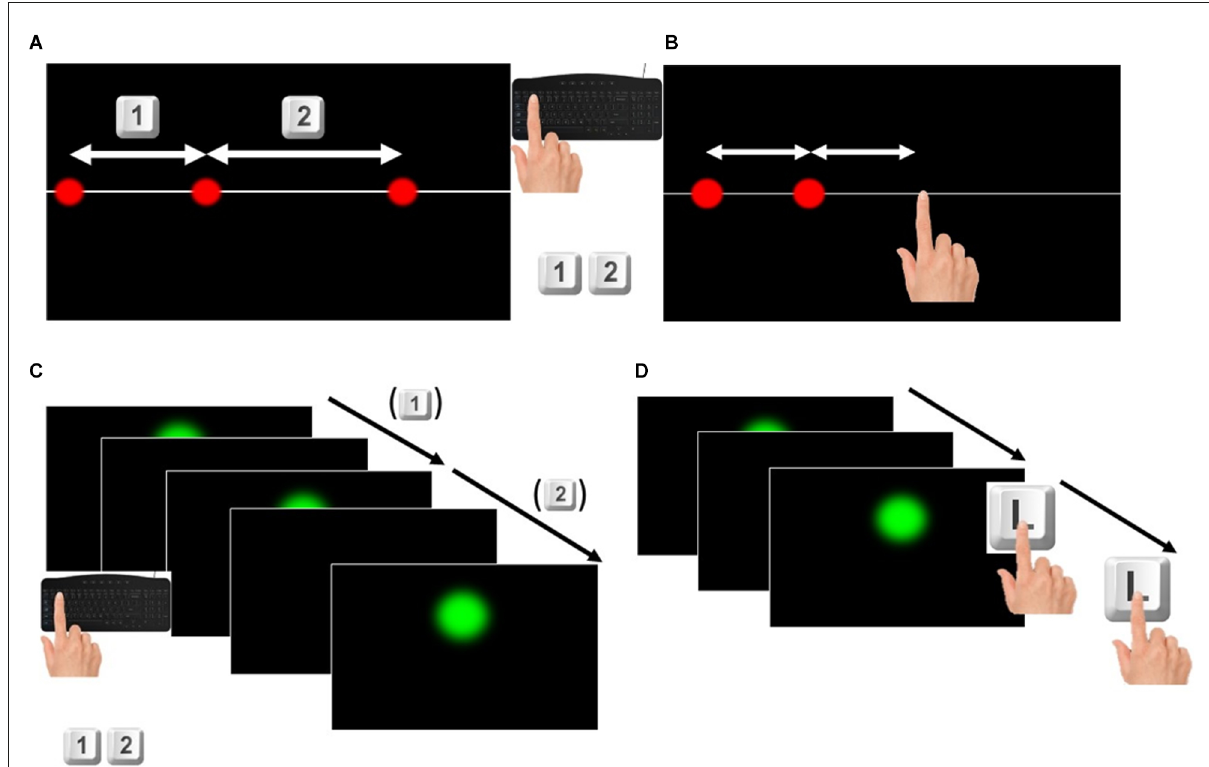
FIGURE1 (A) Space discrimination task. For each trial participants were shown three red dots appearing simultaneously without any time interval between them. They were asked to judge which one was the longer and to press respectively the keys 1 or 2 on the keyboard if the longer was the one on the left or on the right. (B) Space reproduction task. For each trial participants were shown two red dots appearing consecutively without any time interval between them. They were asked to touch the touchscreen at the right of the second dot, to reproduce the distance between the two dots, by taking the second dot as reference. (C) Time discrimination task. For each trial participants were shown three green dots appearing at a certain time interval one from the other. They were asked to judge which one of the two time intervals was longer pressing respectively the keys 1 or 2 if the longer interval was the first (elapsed between the first and the second dot appeared) or the second (elapsed between the second and the third dot appeared). (D) Time reproduction task. For each trial participants were shown two green dots appearing at a certain time interval one from the other. They were asked to touch twice the letter L on the keyboard to reproduce the time interval between the two dots, pressing the start and the end of the time